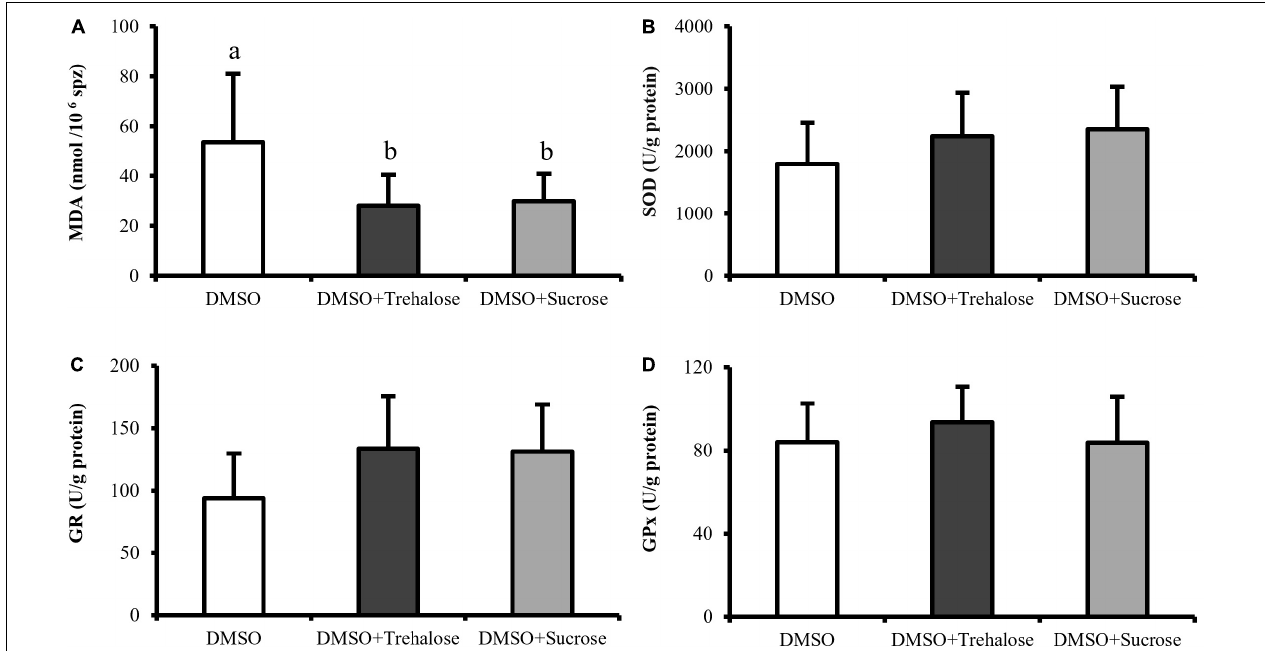
FIGURE 6 | Spectrophotometric assays of C. angulata sperm frozen with 10% DMSO (white bar) and 10% DMSO supplemented with 0.45 M trehalose (black bar) or sucrose (gray bar). (A) Lipid peroxidation through malondialdehyde (MDA) levels ( n = 8). (B–D) Enzyme activity of (B) superoxide dismutase (SOD) ( n = 10), (C) glutathione reductase (GR) ( n = 9) and (D) glutathione peroxidase (GPx) ( n = 10). Results were expressed in mean ± SD. Different letters show differences between cryoprotectant solutions (one-way ANOVA followed by SNK as post hoc test; p <